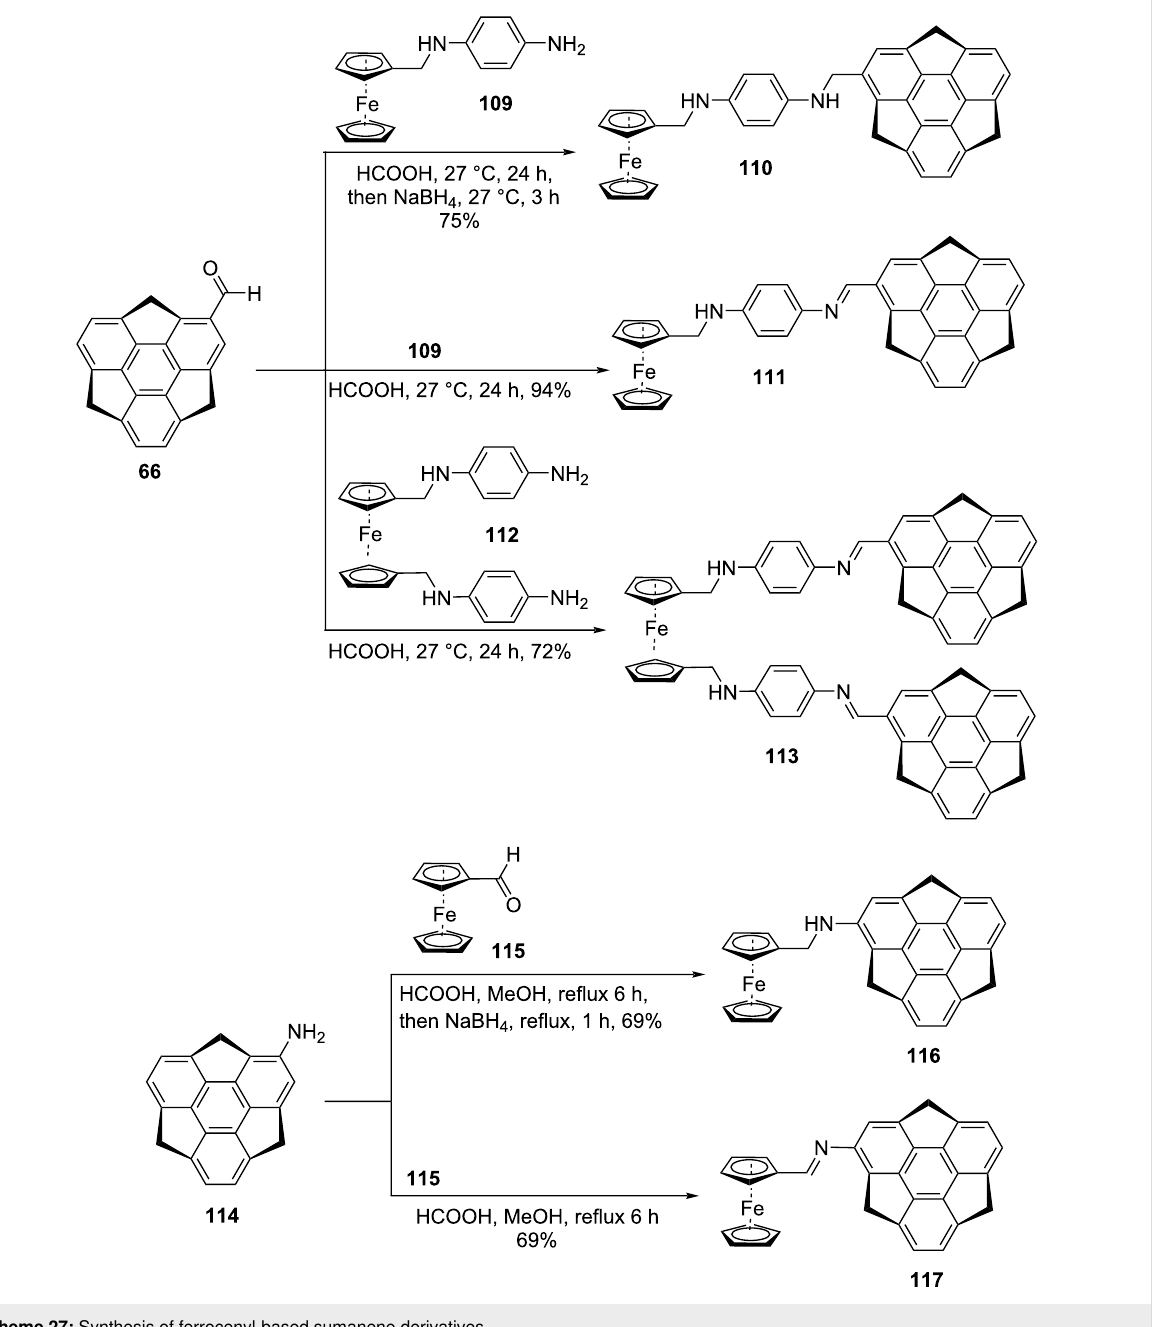
Scheme 27: Synthesis of ferrocenyl-based sumanene derivatives.